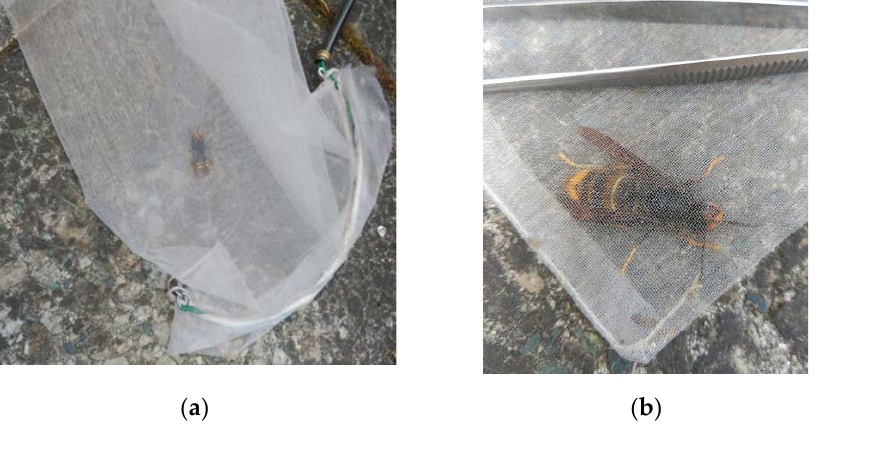
Figure 2. A captured female Vespa velutina specimen by aril netting: ( a ) Walking up into the net bag; ( b ) Trapped in a fold of the tip net bag; ( c ) Inside the designed chamber for venom extraction.